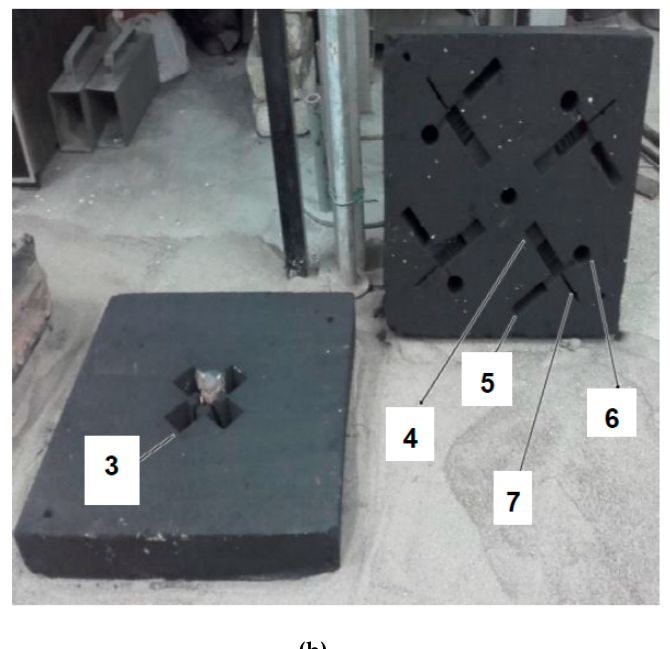
Figure 1. In the mold inoculation pattern for four-work-position (1—Down sprue; 2—Gate; 3—Reaction chamber; 4—Runner; 5—Wedge sample; 6—Cylindrical bar; 7—Flat plate). ( a ) view on the four-work-position of supplied Mg-treated iron simultaneously to four separate reaction test chambers and samples; ( b ) view on the upper and lower